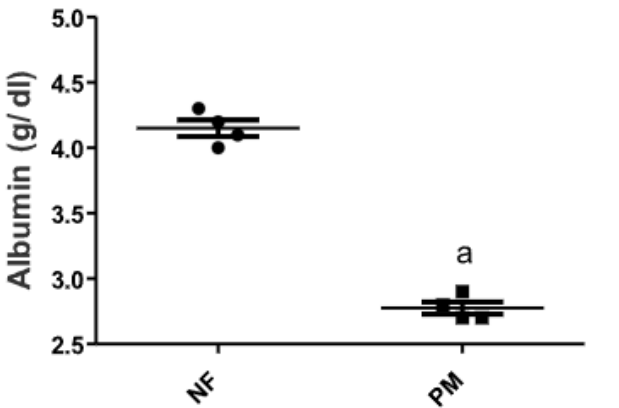
Figure 1. Serum albumin content of PM and/or MSG—fed rat pups. Serum albumin content was assessed in normally fed (NF) and protein malnourished (PM) rat pups. Data presented as mean ± SEM ( n = 8). a depicts significant difference from control NF group at p < 0.05 using unpaired t -test. [The data of the effect of MH on the control NF is not shown as it is not significant].